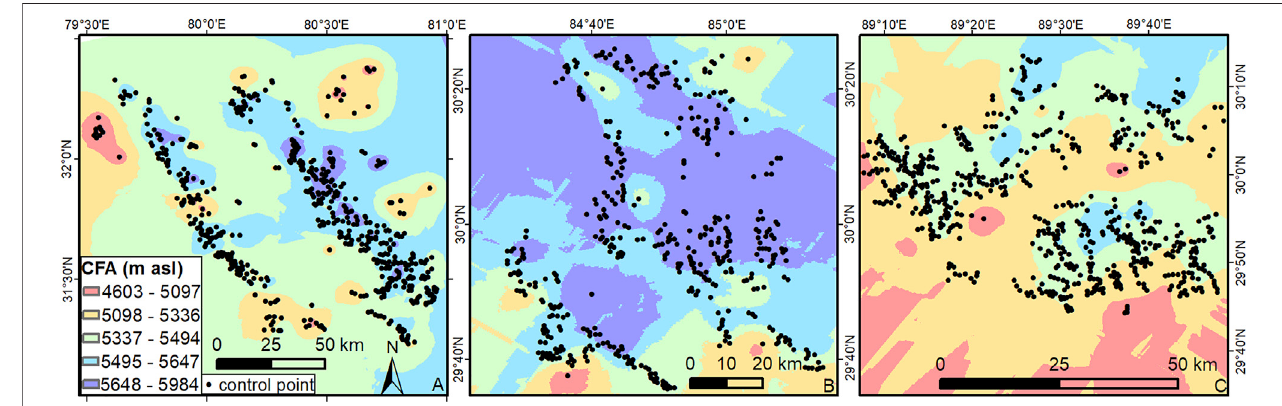
FIGURE 3 | Maps showing the western CFA (A) , central CFA (B) and eastern CFA (C) using a standard kriging